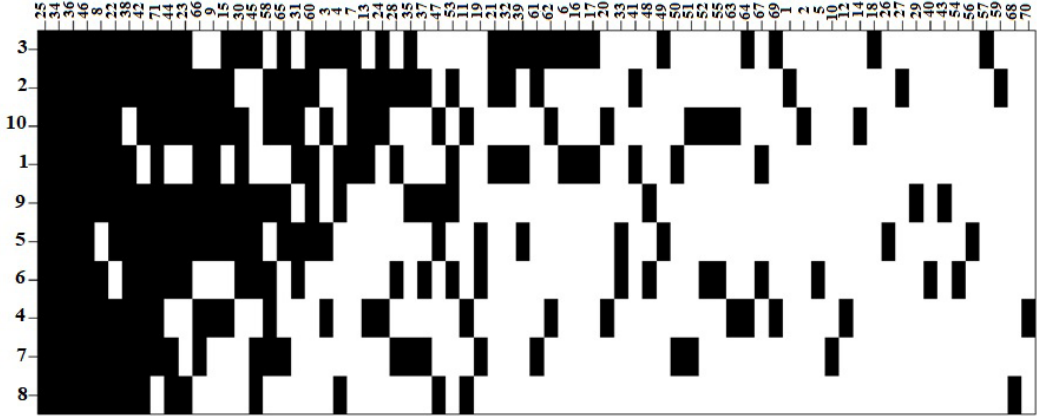
Figure 4. Nestedness order of the composition of diatom communities among the 10 coastal streams in southernmost Brazil. Black lines indicate species occurrence, line numbers indicate the streams, column numbers indicate species (respective species names are in Table 2).